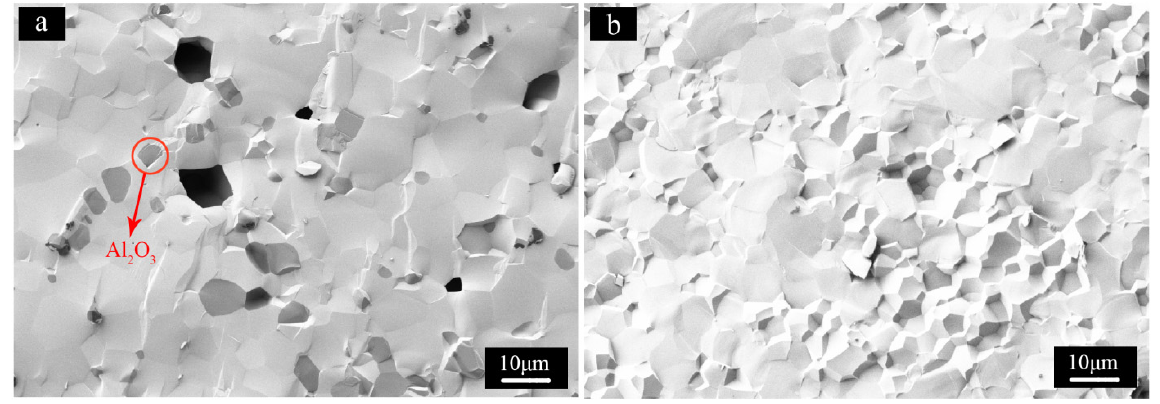
Figure 7. In-line transmittance of ceramics (1.5 mm in thickness) of S1, S4, S5 and S7.